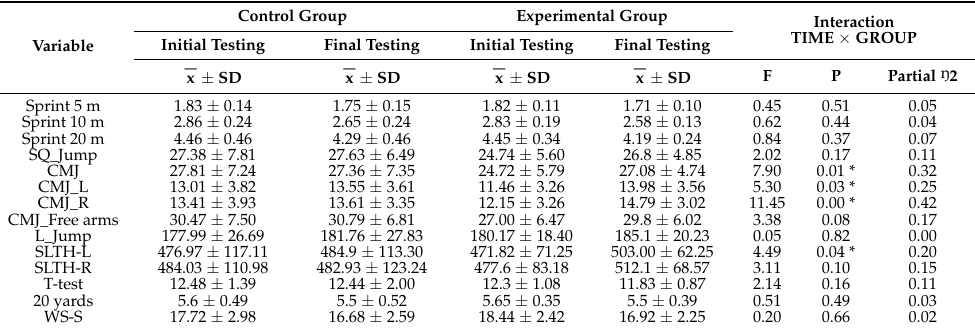
Table 2. Descriptive statistics for both groups in two time points of measurements and results of 2 × 2 mixed-model ANOVA for each